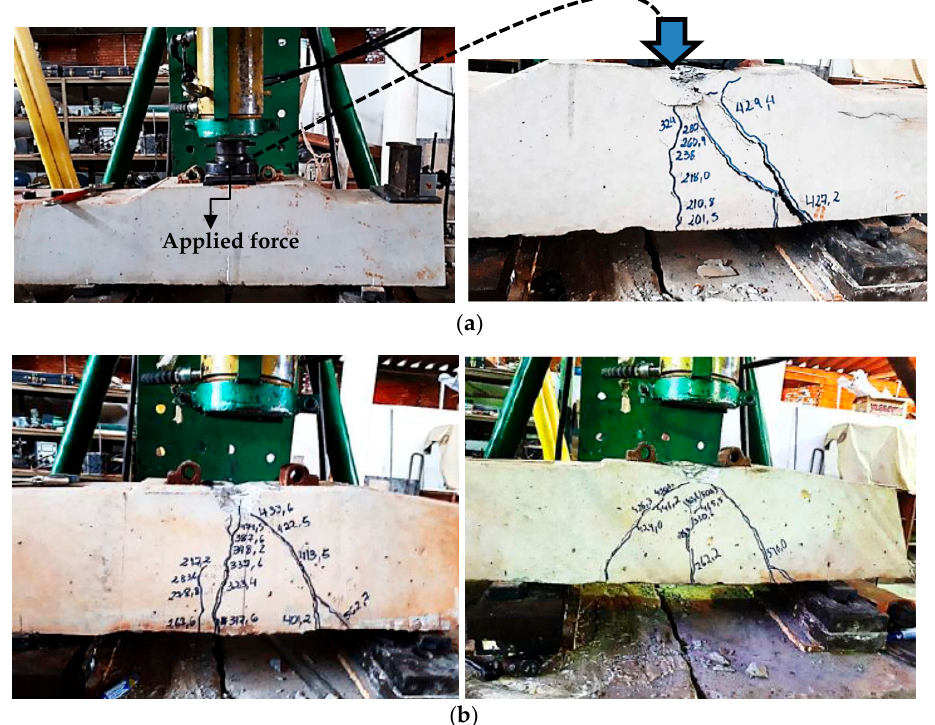
Figure 6. The main failure mode of the sleepers in the positive moment at support: ( a ) failure of the sleepers tested in the Structures Laboratory; and ( b ) failure by shear combined with flexion.